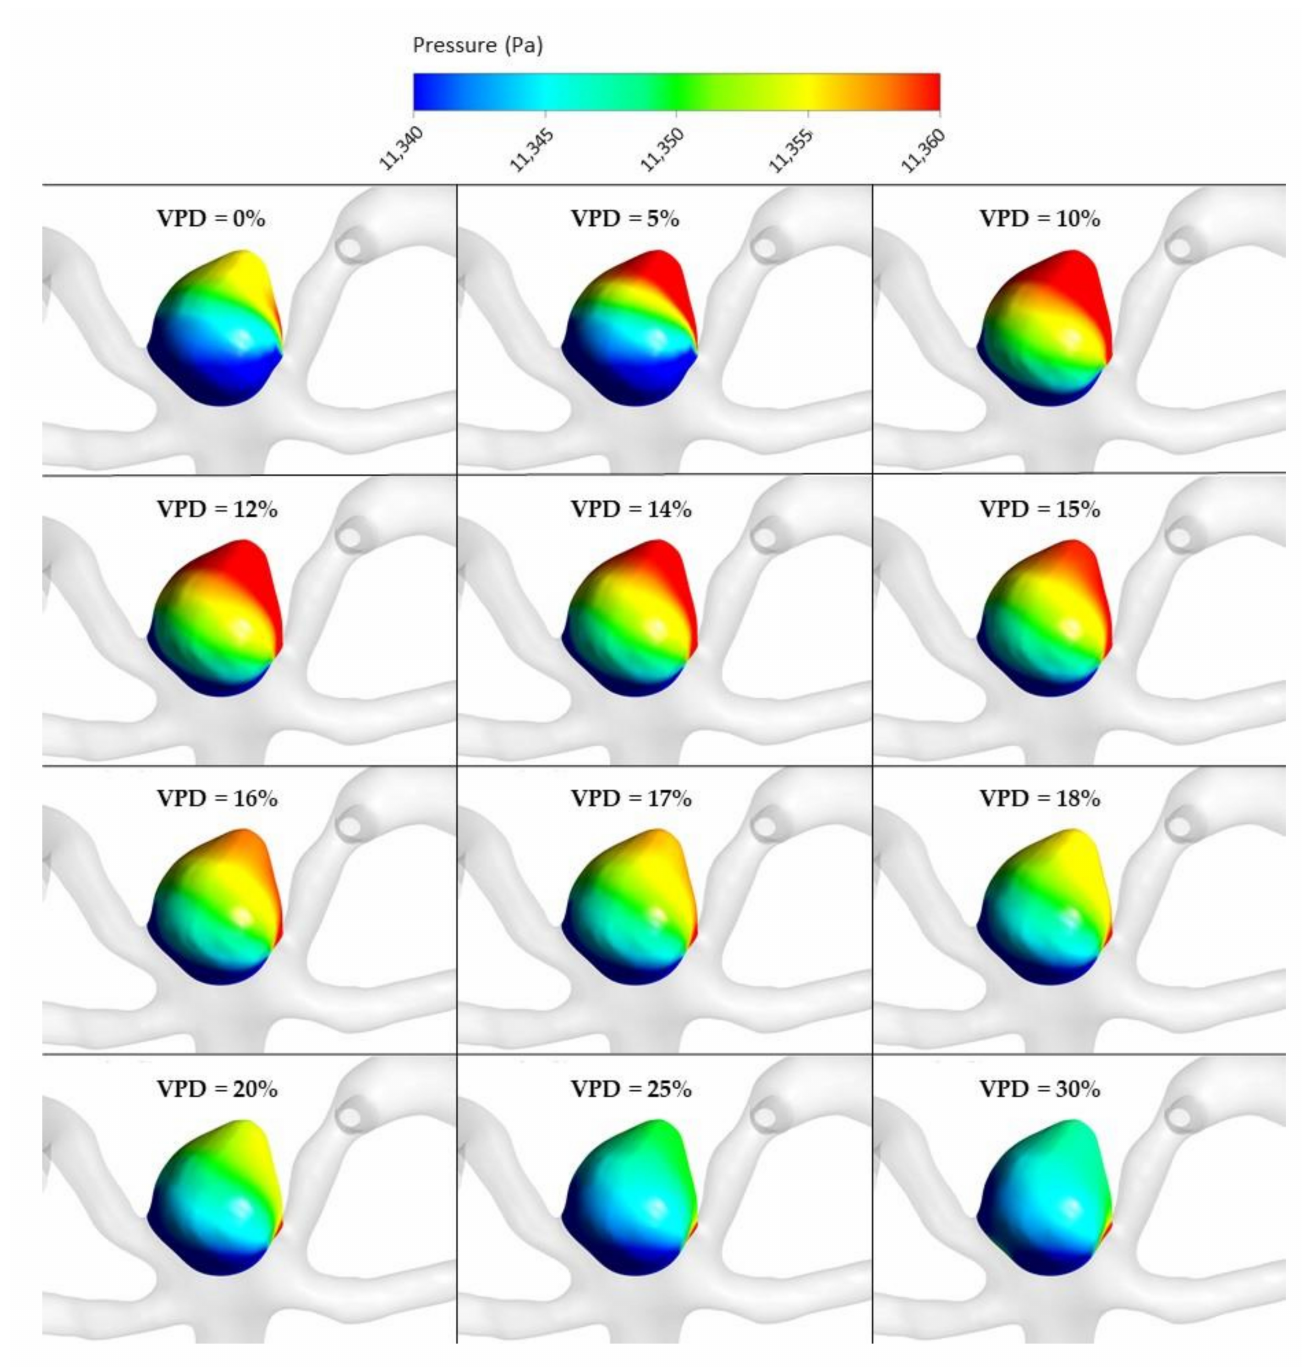
Figure 10. Pressure distribution at aneurysm wall for selected VPD cases; stationary